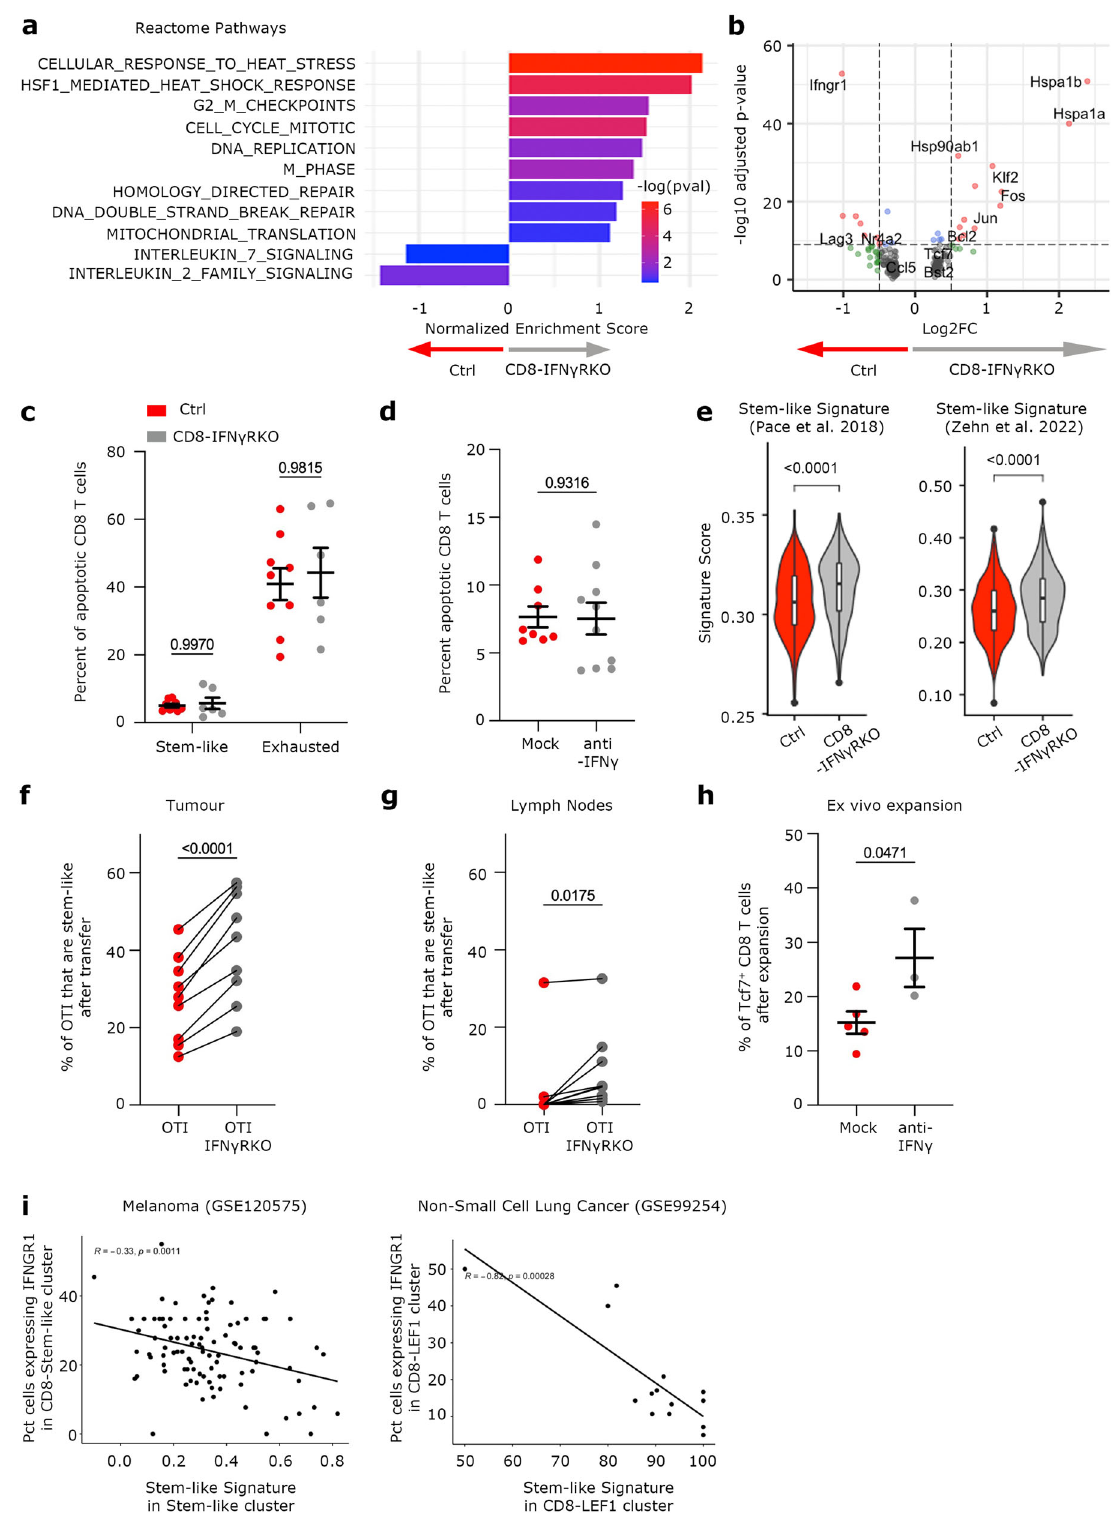
mouseCD8Tcellisolationkit(Mojosort – Biolegend).Whenindicated, cells were labeled with 5 μ M CellTrace Violet (Thermo Fisher) for 15min at 37°C. Mice were adoptively transferred with 2 ×10 6 OTI by intravenous injections between 5 and 7 days after B16-OVA cell engraftment when the tumor was palpable depending on the